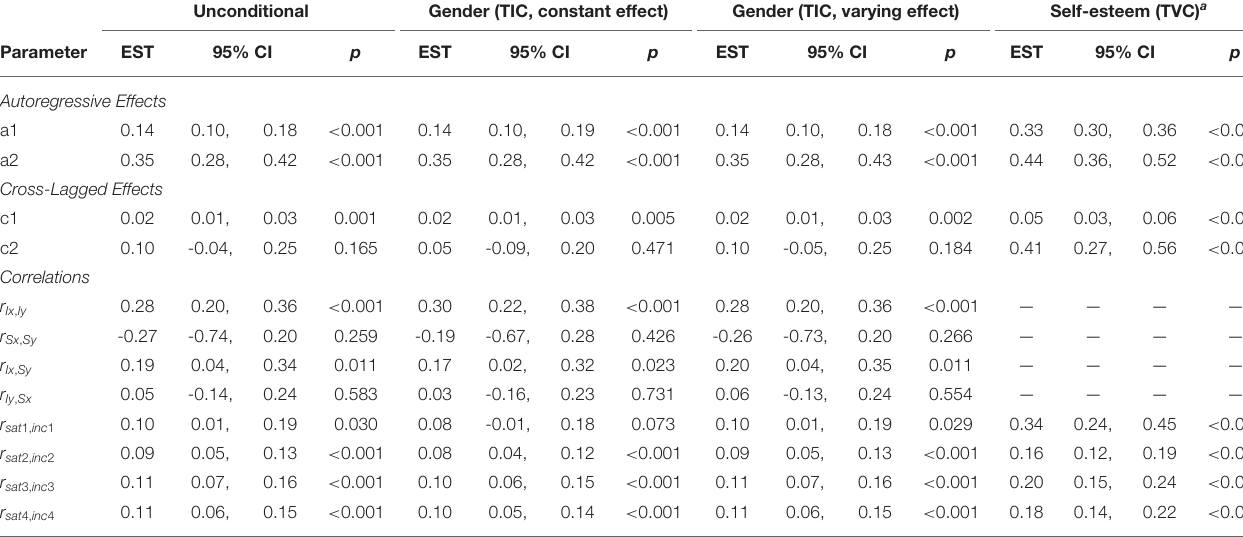
Gender (TIC, constant